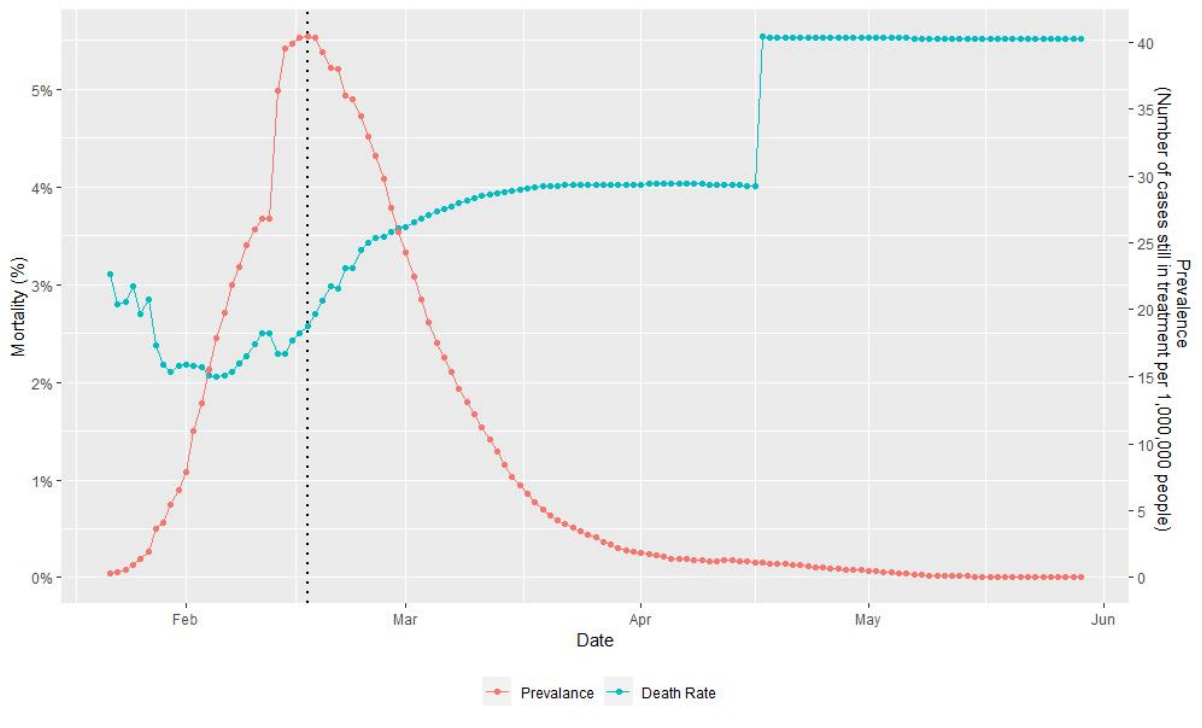
Figure 4. COVID-19 prevalence and mortality reported by China over